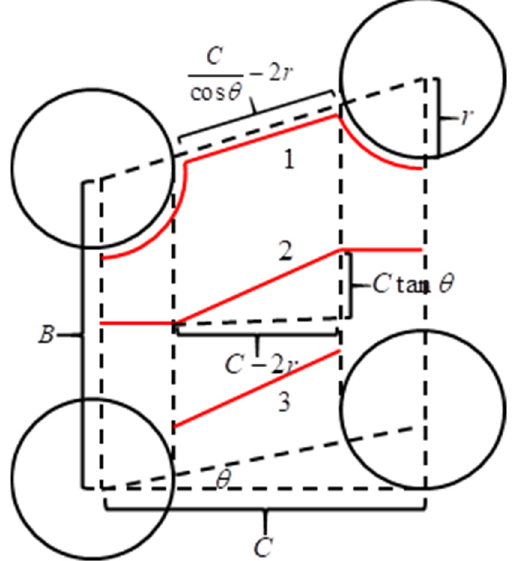
Figure 3. Schematic diagram of potential streamlines.